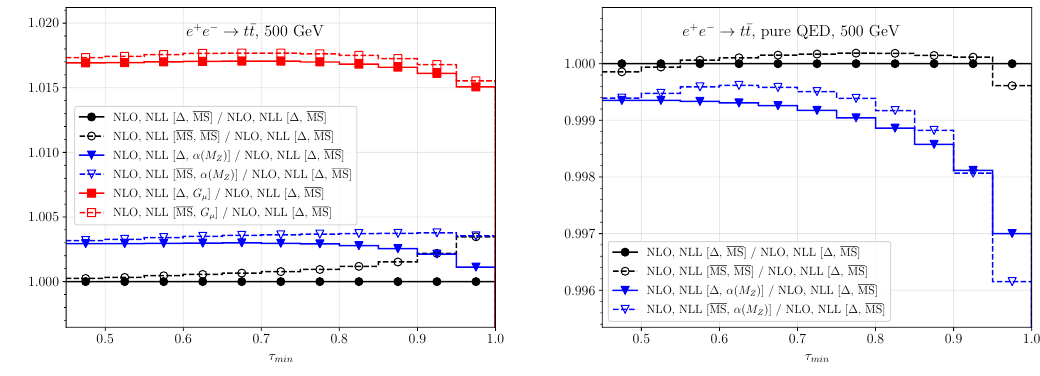
Figure 6 . As in figure 5, for t ¯ t production in the full SM (left panel) and in QED (right panel).